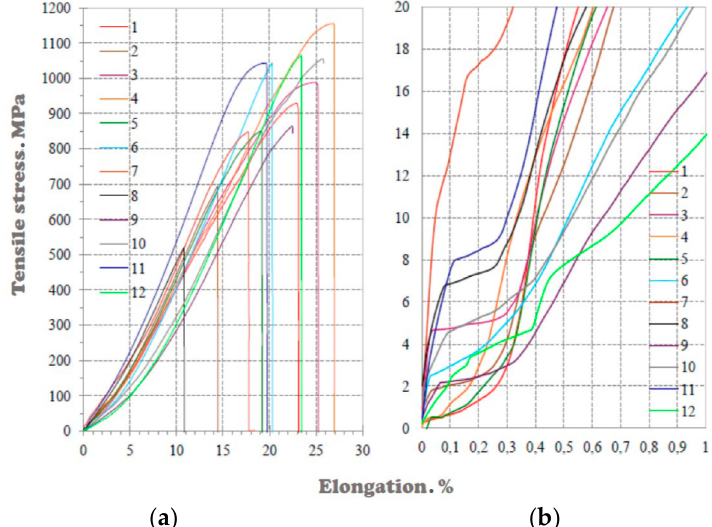
Figure 7. Charts of tensile stress versus elongation for individual micro specimens manufactured under different conditions. ( a ) Full course of tensile curves. ( b ) Initial fragment of these charts at a significant magnification.